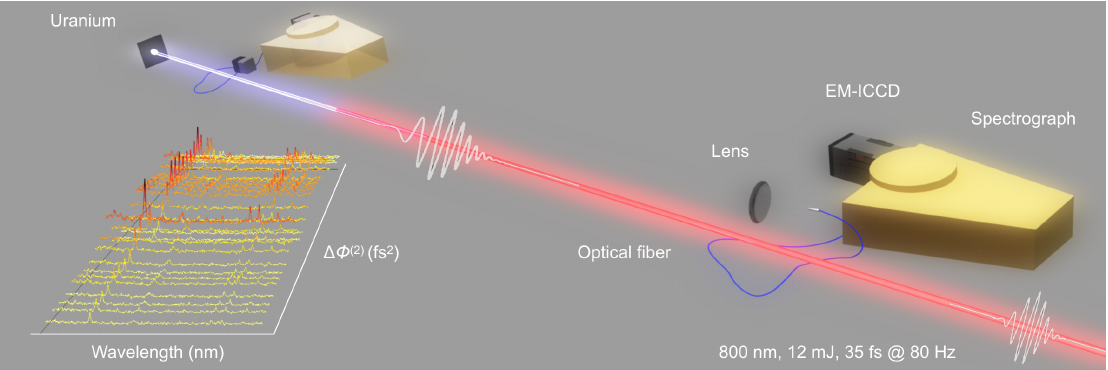
Figure 2. Experimental setup for optimization of uranium plasma emission from close range (left) and its detection from a remote distance (right). The inset shows the change of uranium spectra with a change in the initial spectral phase of an ultrashort laser